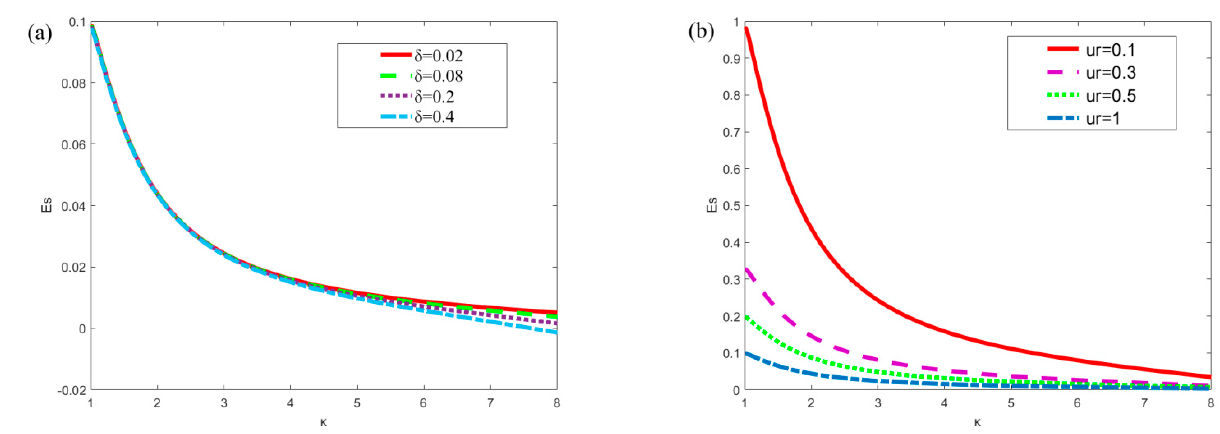
Figure 4. Variation of the dimensionless streaming potential E s with the dimensionless parameter κ for different values of δ and u r ( x = π /4, m = 0.5, n = 0.8, ξ 1 = 0.02, ξ 2 = 0.02, α = 5, β = 5, R = 1, Ha = 1). ( a ) E s at different δ ( u r = 1); ( b ) E s at different u r ( δ = 0.1).